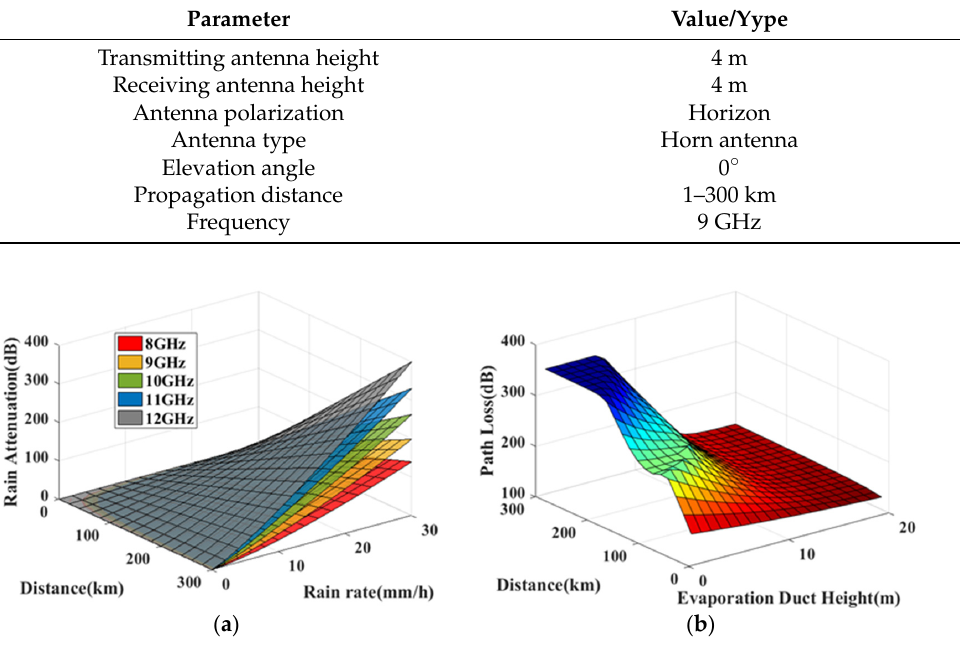
Figure 19. RA ( a ) calculated by the ITU model and PL ( b ) calculated by the PE